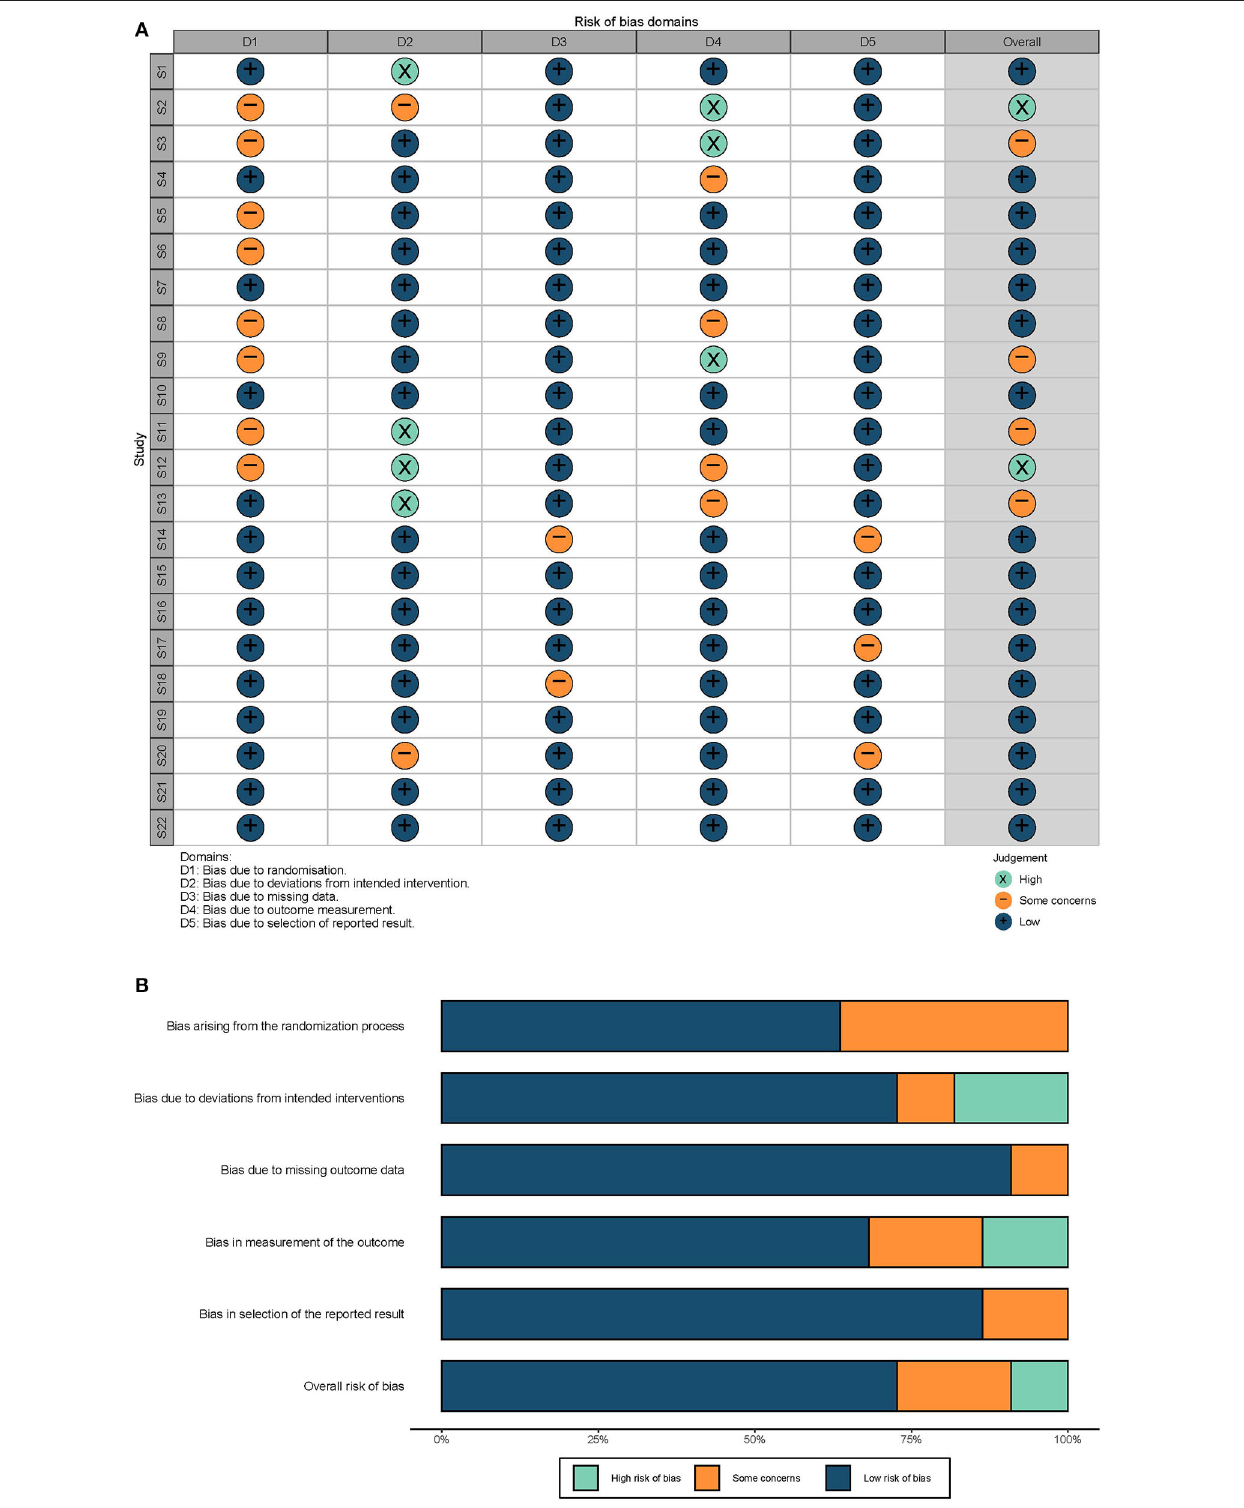
Frontiers in Cardiovascular Medicine |